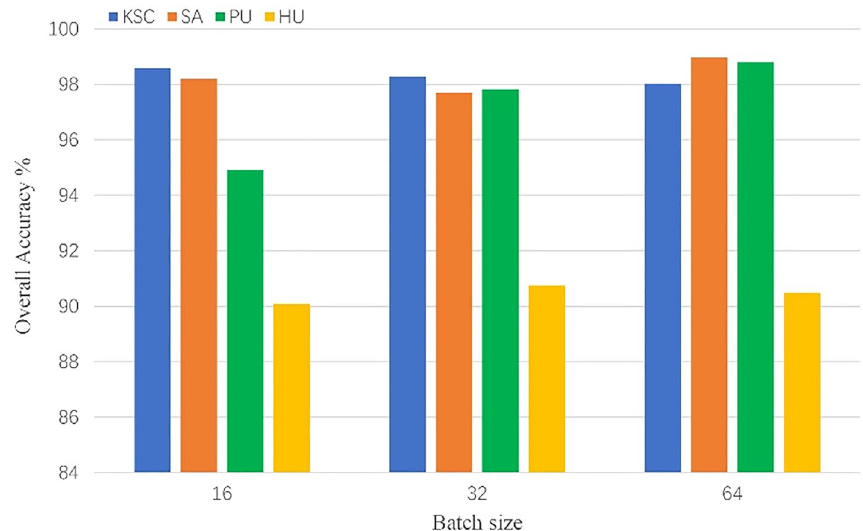
Figure 8. OA (%) of DBFFT with different batch size in the four